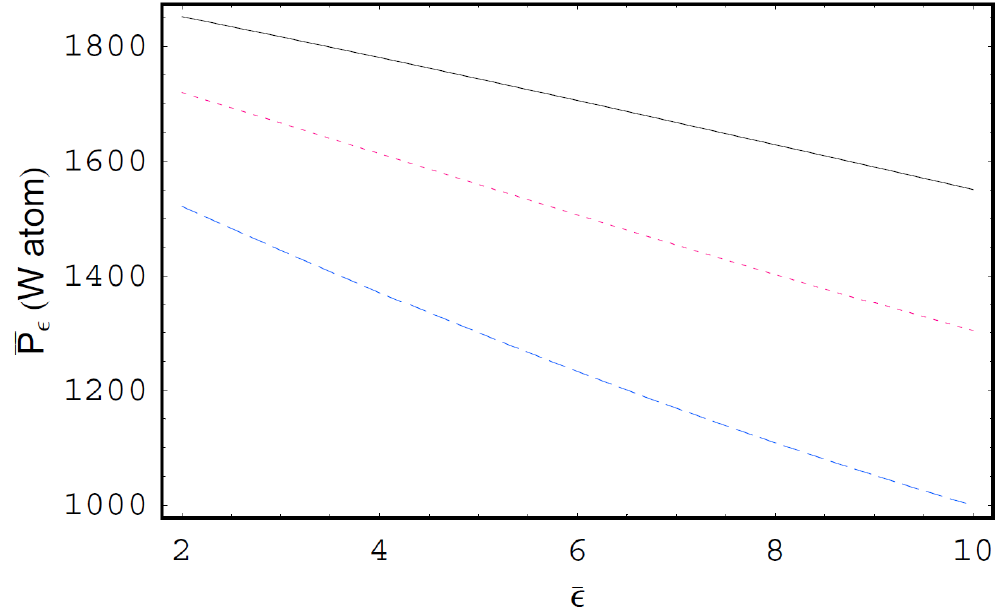
− for the Fe atom including the influence of b e a green dot-dashed line is the Coulomb focused electron–atom bremsstrahlung cross section ( d σ b / d ε ) CF e − a Coulomb focusing. The red dotted line is the electron–atom bremsstrahlung cross section for the Fe atom including the influence of Coulomb focusing. The red dotted line is the electron–atom ( / ) d d σ ε − for the Fe atom without the Coulomb focusing effect. b e a bremsstrahlung cross section ( d σ b / d ε ) e − a for the Fe atom without the Coulomb focusing e ff ect.